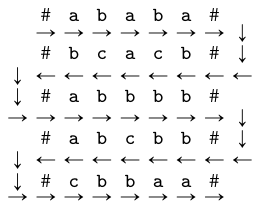
Figure 3. How a BFA processes a